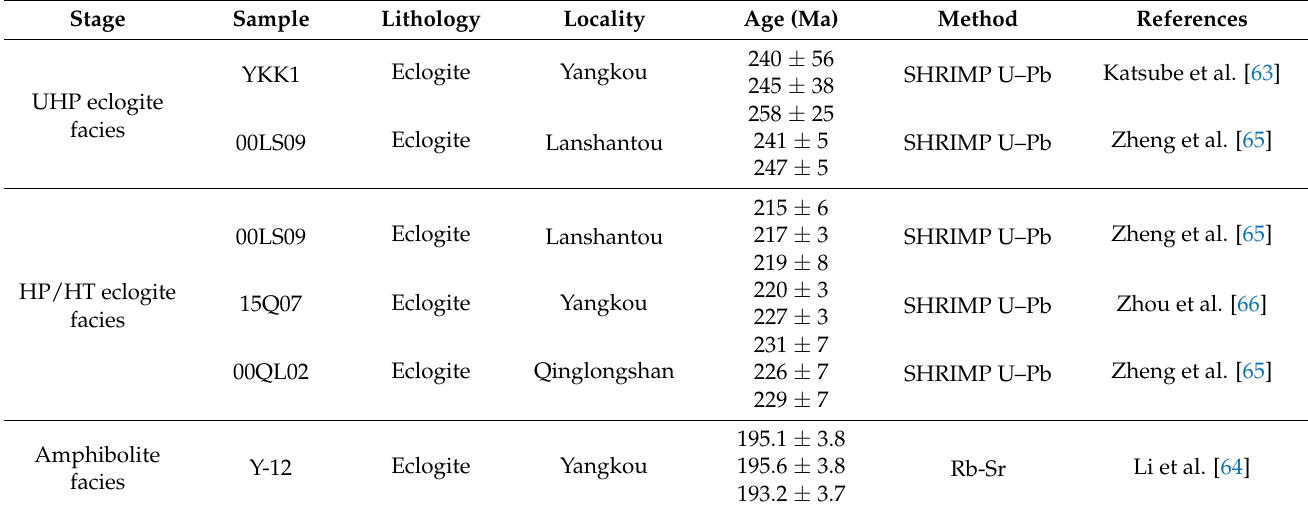
Figure 13. A summary of zircon ages of eclogites in the Sulu area. Metamorphic ages of UHP eclogite facies are from Katsube et al. [63] and Zheng et al. [65], Metamorphic ages of HP/HT eclogite facies retrograde metamorphism are from Zheng et al. [65] and Zhou et al. [66], Metamorphic ages of amphibolite eclogite facies retrograde metamorphism are from Li et al. [64]. Table 4. Reported geochronological date for eclogites in the Sulu